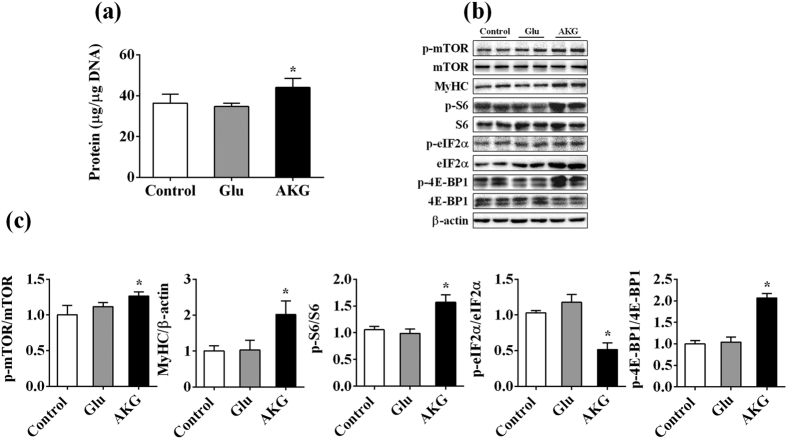
Glutamate failed to promote protein synthesis in C2C12 myotubes.C2C12 cells were cultured for 6 d in a differentiation medium. C2C12 myotubes were then exposed to glutamate (2 mM) and AKG (2 mM) for 48 h. (a) Total protein levels. (b) The phosphorylation level of mTOR, S6, 4E-BP1, eIF2a, and MyHC. (c) The statistical analyses results of the Western blot of the phosphorylation level of mTOR, S6, 4E-BP1, eIF2a, and MyHC for (b). Data are presented as mean ± SEM. *means P < 0.05 compared with the control. β-actin served as a housekeeping gene control.